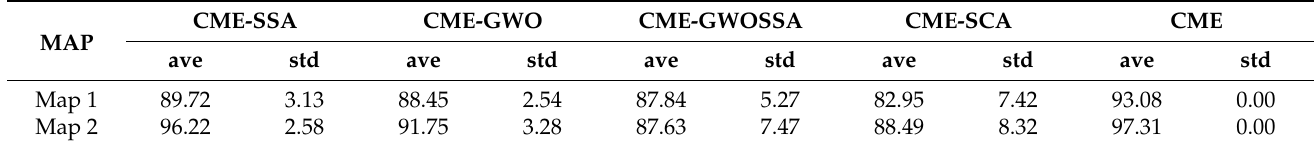
Table 1. Average of the percentage of the explored area after 30 runs, with 100 iterations